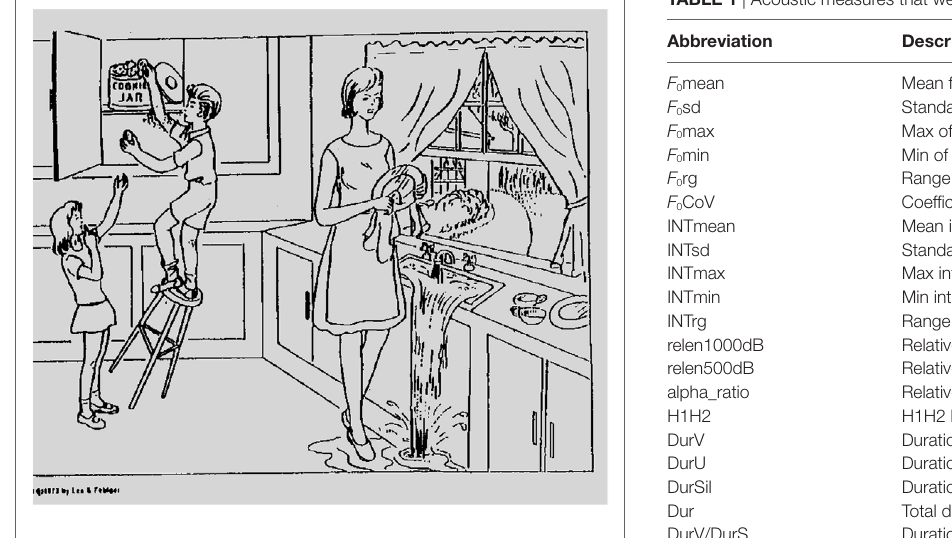
FigUre 1 | The stimulus for the picture descriptions (the “Cookie Theft”